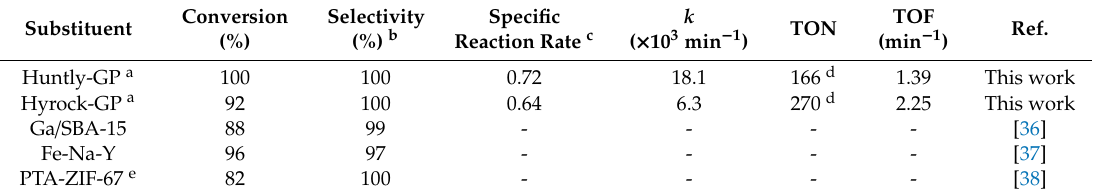
Table 3. Comparison of the catalytic reactivity of various heterogeneous catalysts in Friedel-Crafts acylation of anisole. k Conversion Selectivity Specific TOF Ref. Substituent TON (min − 1 ) (%) (%) b Reaction Rate c ( × 10 3 min − 1 ) Huntly-GP a 100 100 0.72 18.1 166 d 1.39 This work Hyrock-GP a 92 100 0.64 6.3 270 d 2.25 This work Ga / SBA-15 88 99 - - - - [36] Fe-Na-Y 96 97 - - - - [37] PTA-ZIF-67 e 82 100 - - - -